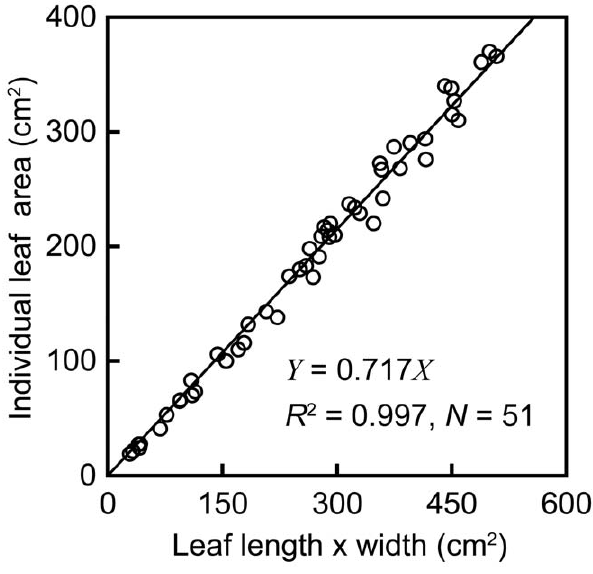
Figure 2. Similarity among individual leaves. Each open circle indicates one harvested leaf ( n =51). The solid line shows the ordinary least-squares regression, which was forced through the origin: Leaf area (cm 2 )=0.717 (length 6 width) ( r 2 =0.997, n =51, p ,